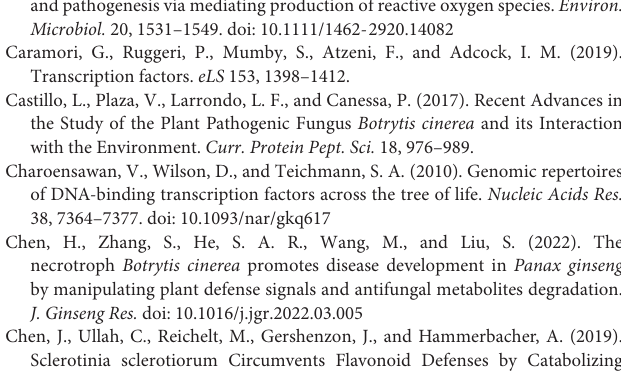
Supplementary Figure 1 | Protein blast analysis revealed conserved domains in BcSpd1. The amino acid of BcSpd1 was submitted to NCBI Blast (https://blast.ncbi.nlm.nih.gov/Blast.cgi) and the conserved domain was indicated. Supplementary Figure 2 | Construction of the BcSpd1 gene deletion mutants ( (cid:49) BcSpd1 ). Replacement of BcSpd1 with a hygromycin gene (Hyg) cassette by homologous recombination (A) and PCR verification of transformants (B) . The agarose gels depict (in order): PCR amplification of Hyg genes, PCR amplification of BcSpd1 genes (one heterozygotic line, four transformed homozygotic lines). (C) qPCR analysis of BcSpd1 genes in wild-type B0510 and the indicated (cid:49) BcSpd1 mutants. Supplementary Figure 3 | Construction of the complemented lines of BcSpd1 ( (cid:49) BcSpd1- C). Supplementary Figure 4 | Phenotype of BcSpd1 deletion mutants showed less pathogenicity than wild-type B. cinerea B0510. Supplementary Figure 5 | GO and KEGG analysis of differentially expressed genes. (A) GO analysis of differentially expressed genes observed in both B05.10 and (cid:49) BcSpd1 affected Col-0 plants compared with CK. (B) KEGG analysis of differentially expressed genes observed in both B05.10 and (cid:49) BcSpd1 affected Col-0 plants compared with CK. (C) GO analysis of differentially expressed genes observed only in (cid:49) BcSpd1 affected Col-0 plants compared with CK. (D) GO analysis of differentially expressed genes observed only in B05.10 affected Col-0 plants compared with CK. Supplementary Figure 6 | Heatmap analysis of differentially expressed genes encoding transcription factors among CK, B05.10, and (cid:49) BcSpd1 treated Col-0 plants. Supplementary Figure 7 | Heatmap analysis of differentially expressed genes response to ABA among CK, B05.10, and (cid:49) BcSpd1 treated Col-0 plants. Supplementary File 1 | The top 100 differentially expressed genes in both B05.10- and (cid:49) BcSpd1- treated plants compared with CK. Supplementary File 2 | GO enrichment pathway analysis of the differentially expressed genes in both B05.10 and (cid:49) BcSpd1 treated Col-0 plants compared with CK. Supplementary File 3 | Differentially expressed genes involved in plant hormones signal transduction among CK, B05.10, and (cid:49) BcSpd1 treated Col-0 plants. Supplementary File 4 | Differentially expressed genes involved in flavone and isoflavonoid biosynthesis pathway among CK, B05.10, and (cid:49) BcSpd1 treated Col-0 plants. Supplementary File 5 | Differentially expression genes encoding transcription factors among CK, B05.10, and (cid:49) BcSpd1 treated Col-0 plants. Supplementary File 6 | Differentially expressed genes response to ABA among CK, B05.10, and (cid:49) BcSpd1 treated Col-0